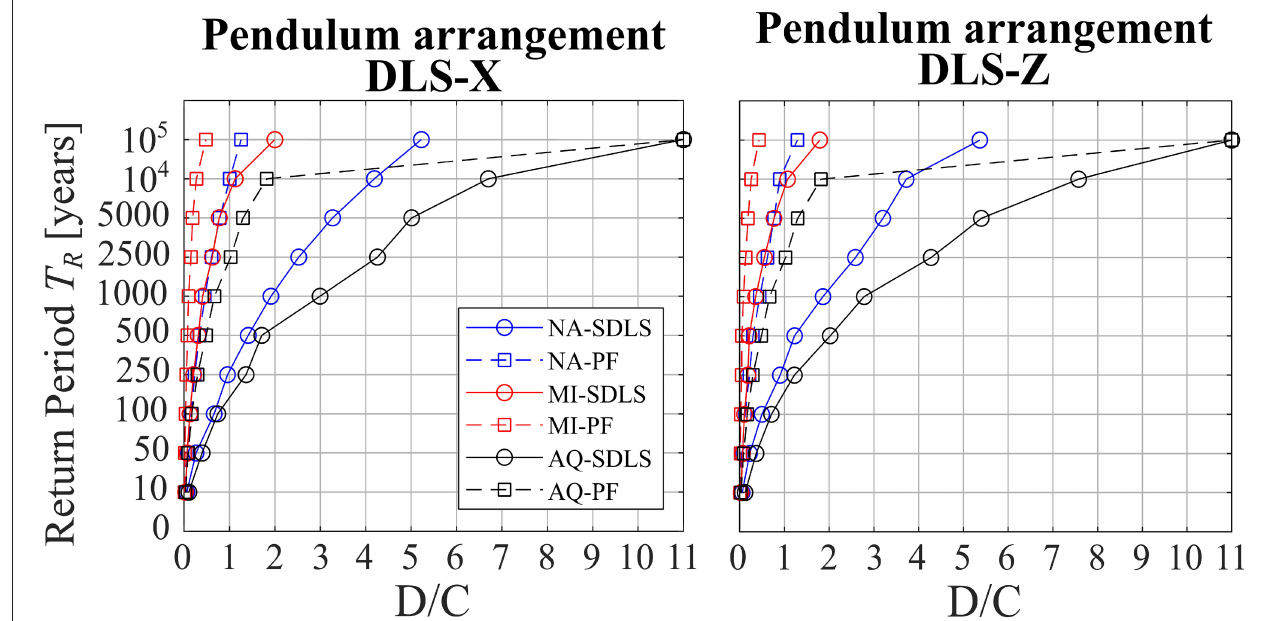
FIGURE 9 | The mean value of D/C ratio with reference to Damage Limit State for all considered panel arrangement at three considered sites.